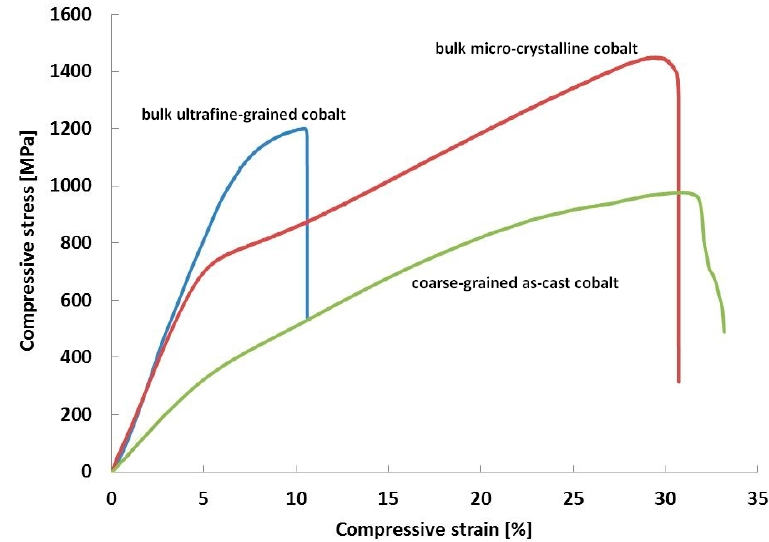
Figure 4. Compressive stress-strain curves for the bulk ultrafine-grained, micro-crystalline and coarse-grained as-cast cobalt sample. coarse-grained as-cast cobalt